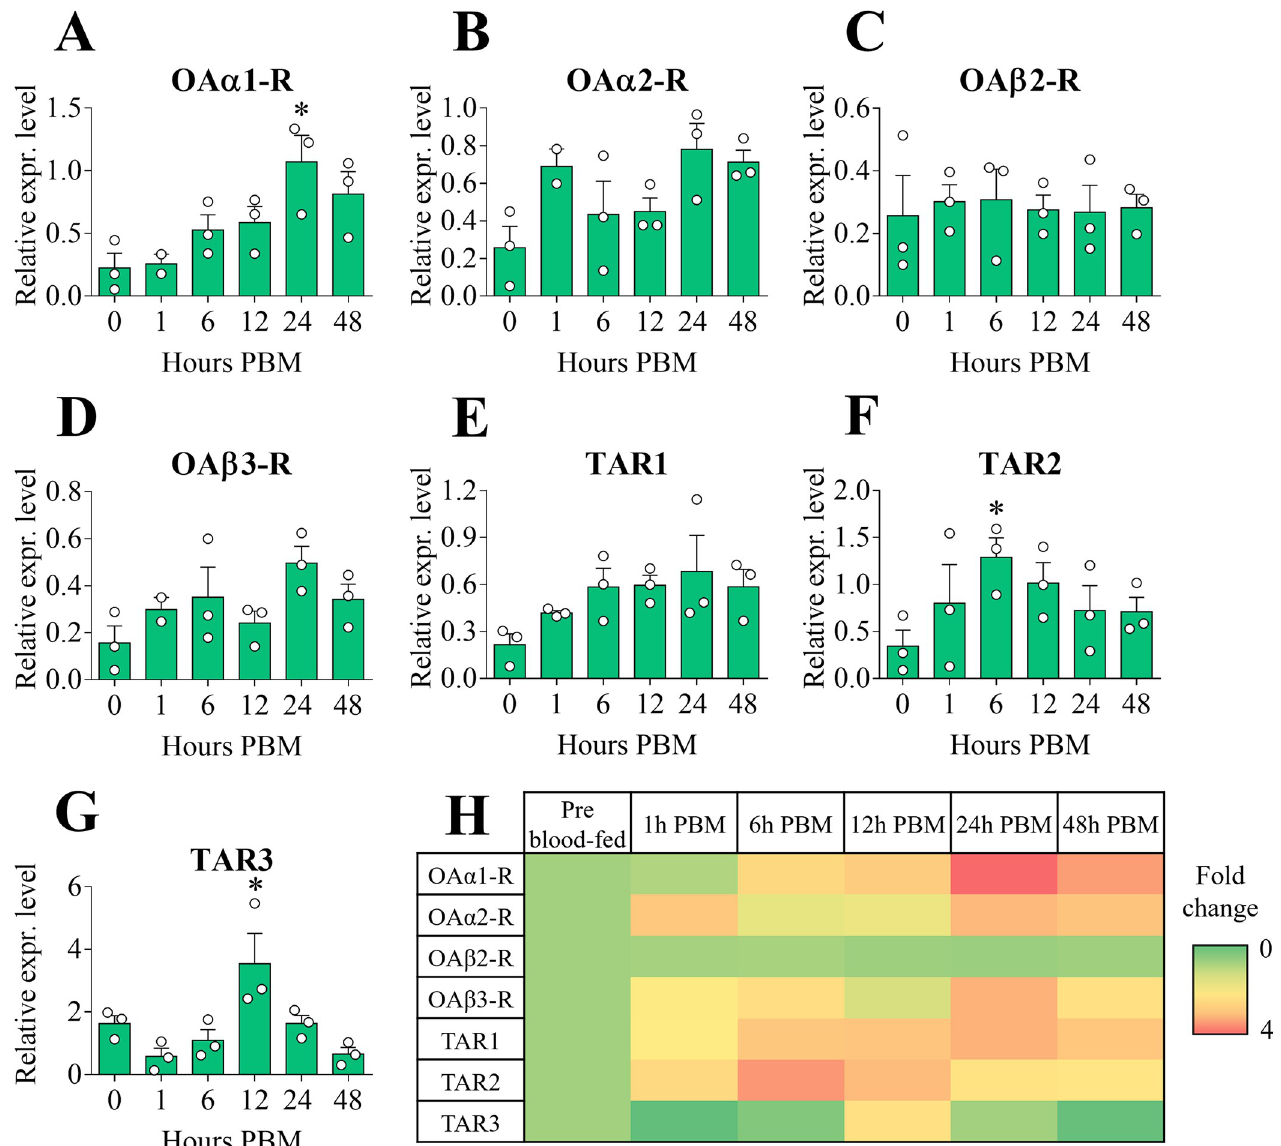
Fig 5. Expression patterns of OA and TA receptor transcripts among female adult A . aegypti midgut post blood meal (PBM) time points. AaOA α 1-R ( A ), AaOA α 2-R ( B ), AaOA β 2-R ( C ), AaOA β 3-R ( D ), AaTAR1 ( E ), AaTAR2 ( F ) and AaTAR3 ( G ). Setting all the receptor expression levels in pre blood-fed condition to 1, a heat map was assembled ( H ). Data represent means ± SEM of three biological replicates. � p < 0.05 vs pre blood-fed condition (0 hours PBM) according to one-way ANOVA followed by multiple comparisons Bonferroni post hoc